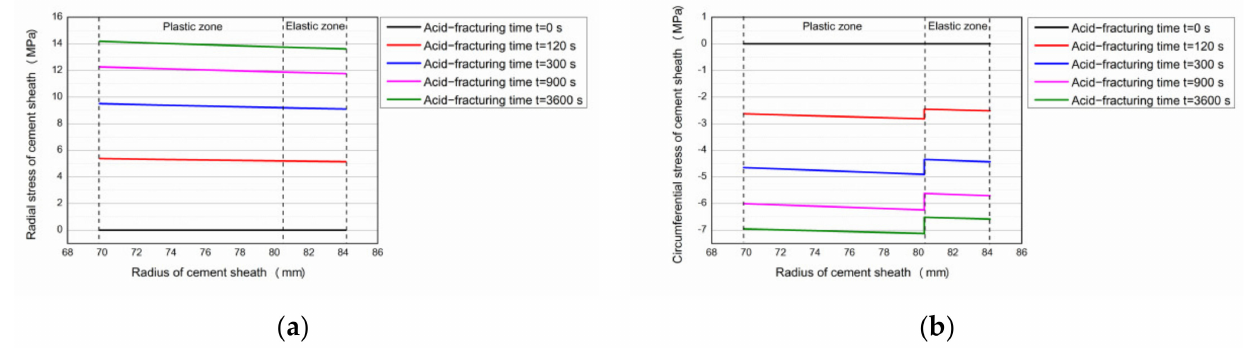
Figure 10. Differential temperature stress of cement sheath during acid fracturing. ( a ) Radial differential stress; ( b ) Circumferential differential stress.